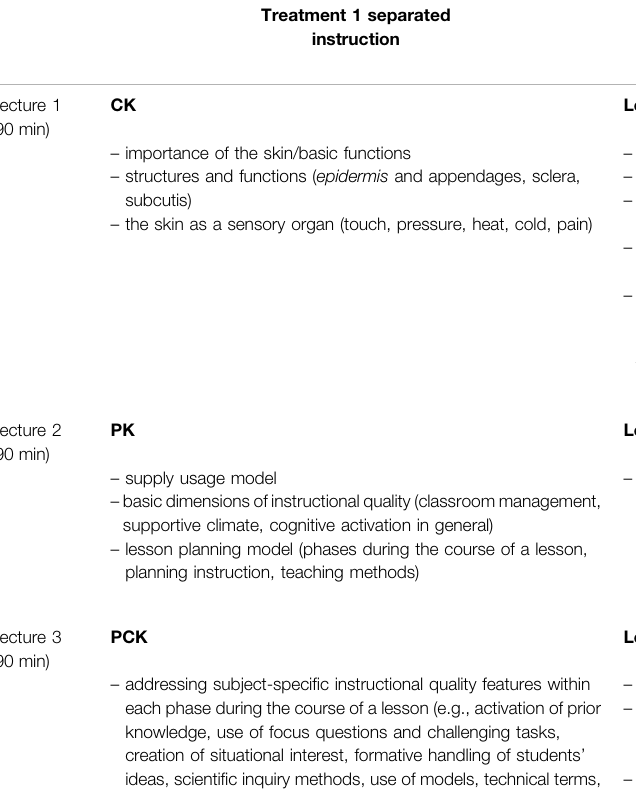
TABLE 2 | Overview of the content of the three lectures of each